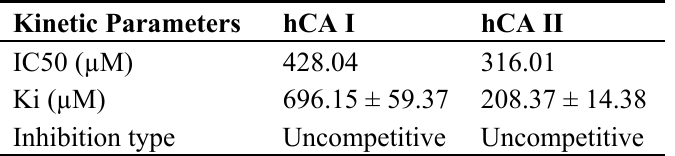
Table 1. The inhibition profile of capsaicin on purified hCA I, and hCA II from